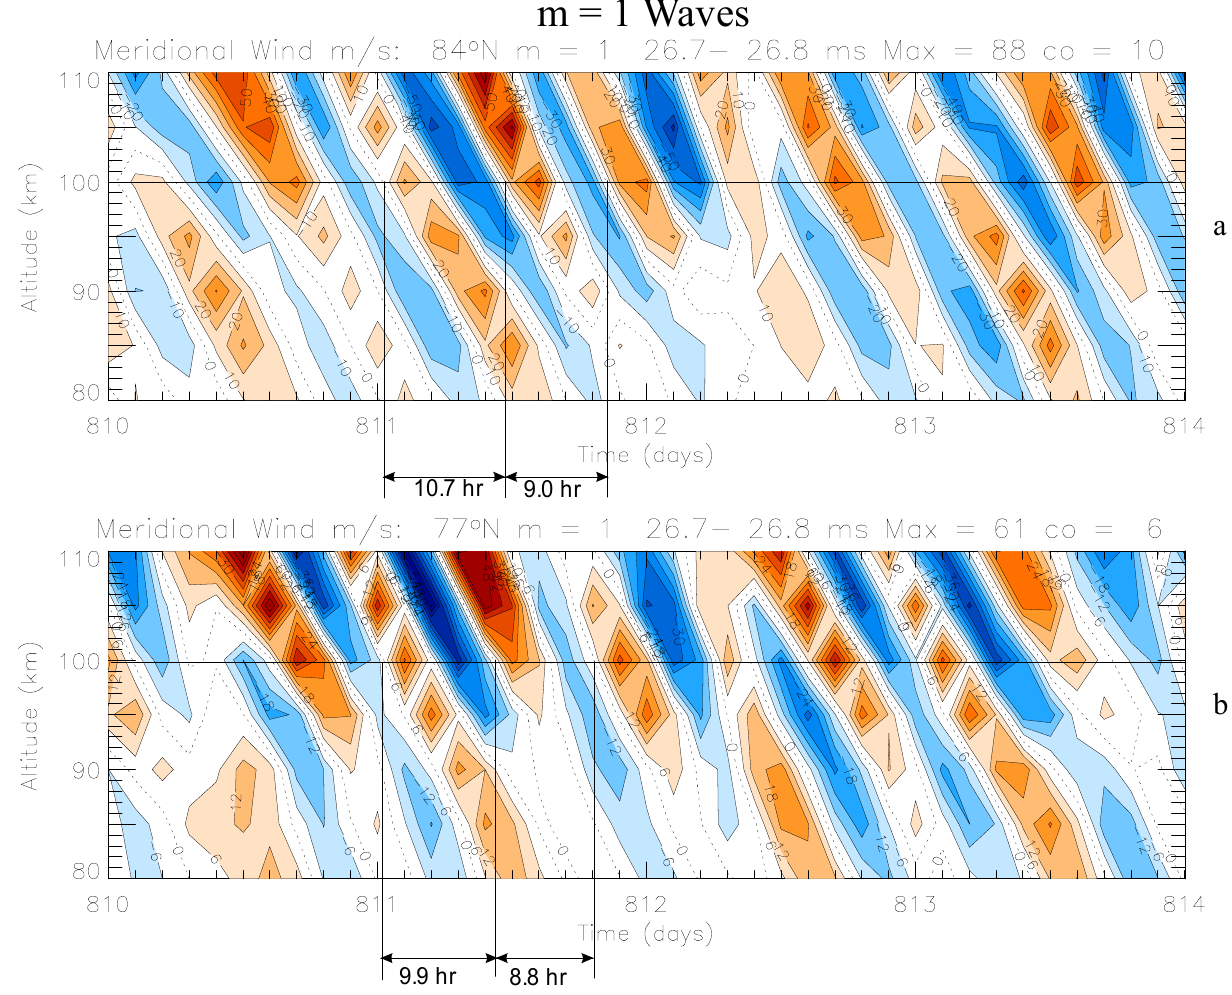
Fig. 1. Time-altitude contour plot of meridional winds for zonal wave number m=1 at 84 ◦ N ( a ) and 77 ◦ N ( b ) , Gaussian points, during March (late northern winter) of the third model year when waves with periods around 10h are prominent at polar latitudes. The contour intervals are 10m/s (a) and 6m/s (b). For illustrative purpose, two examples of wave periods are identified from zero intersections. (To reduce output, the model results are recorded with 5-km altitude intervals, which causes the contours to appear